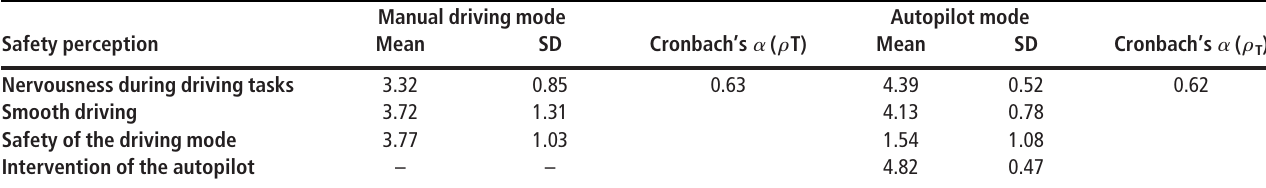
Table 4 Results of the safety perception survey Safety perception